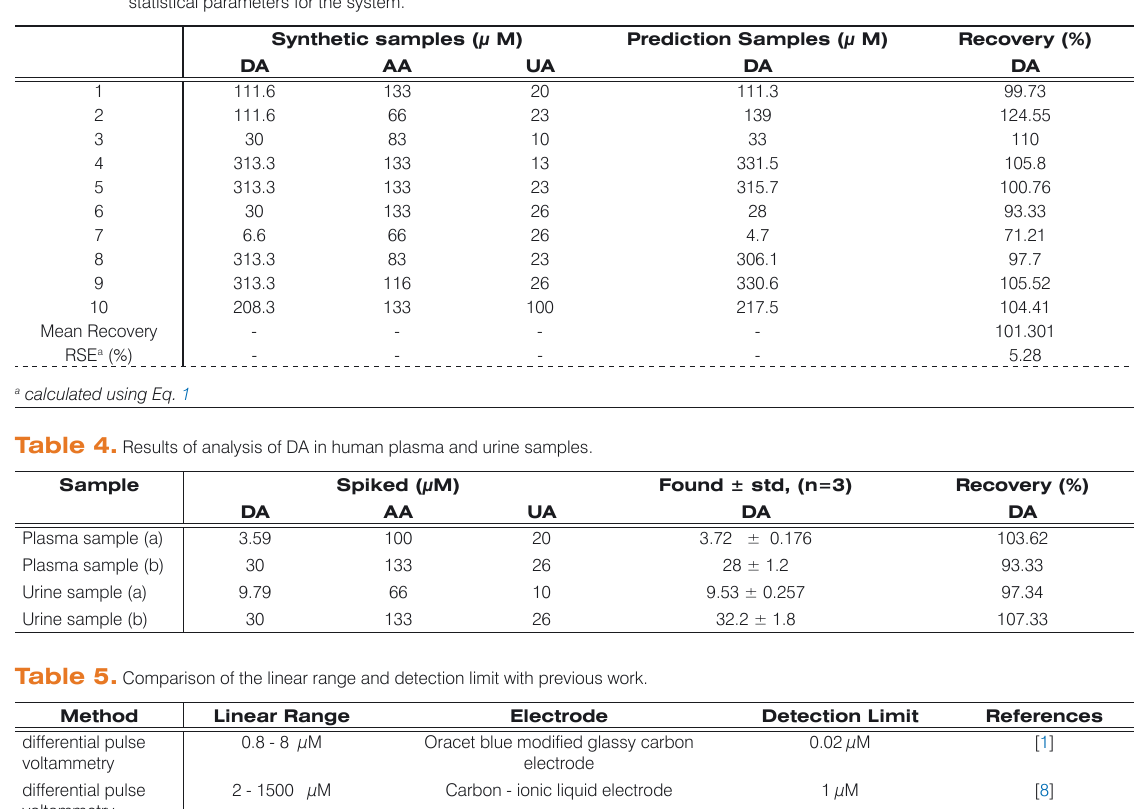
Table 3. Composition of synthetic ternary mixtures of DA, UA and AA, the prediction of DA, its recovery obtained by the PLS-1 model and the statistical parameters for the system.